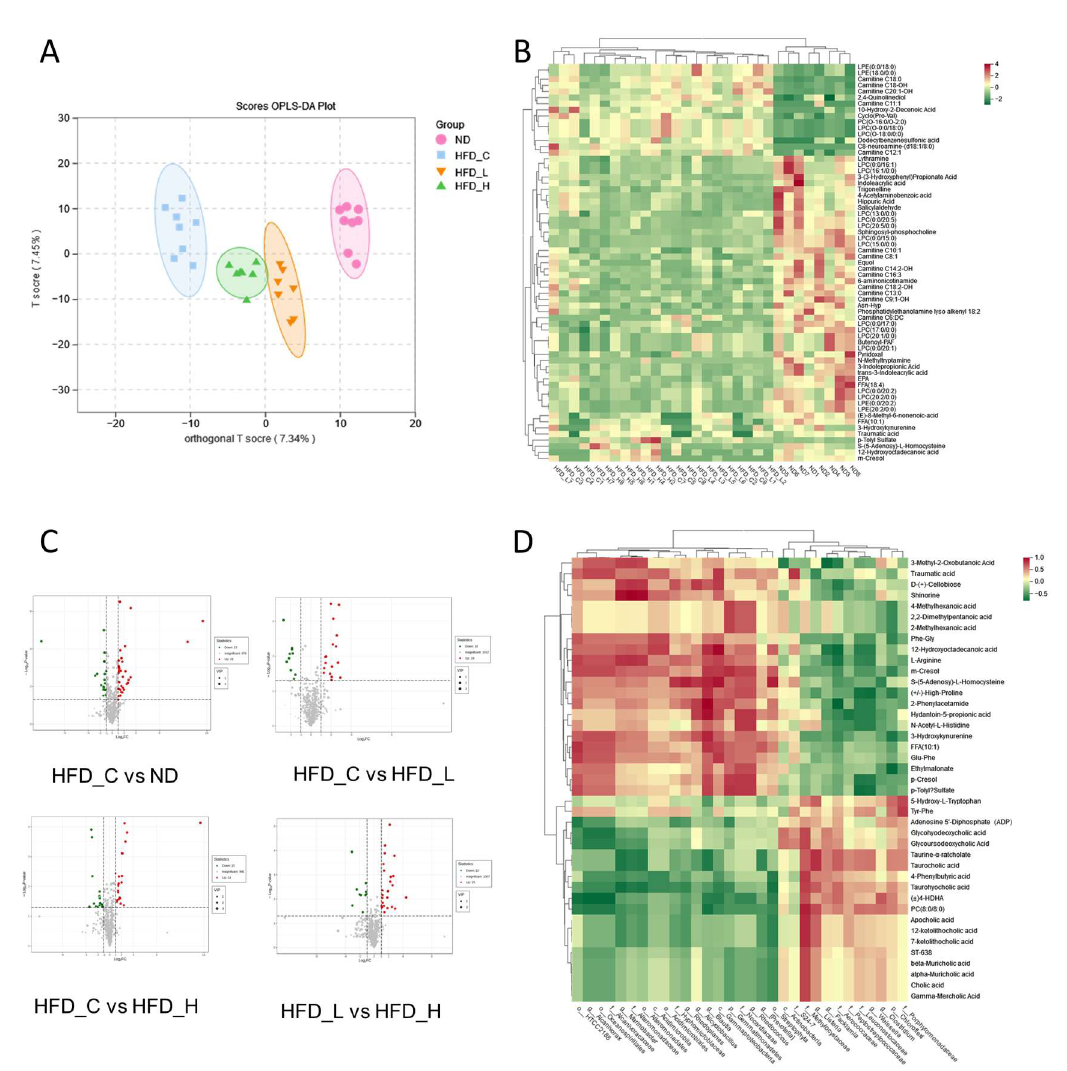
Figure 6. Supplementation of symbiotics altered the metabolic patterns. ( A ) Orthogonal partial least squares-discriminant analysis (OPLS-DA) score plots of plasma metabolic profiling of the ND, HFD_C, HFD_L and HFD_H groups. ( B ) The relative amount of metabolites concurrently varied in the ND, HFD_C, HFD_L and HFD_H groups is transformed into Z scores in the heatmap. ( C ) Volcano plots for differentially expressed metabolites in two-group comparisons. ( D ) The relationship between the 46 different metabolites and the 67 core microbiota in HFD_C and HFD_H is estimated by Spearman’s correlation analysis.